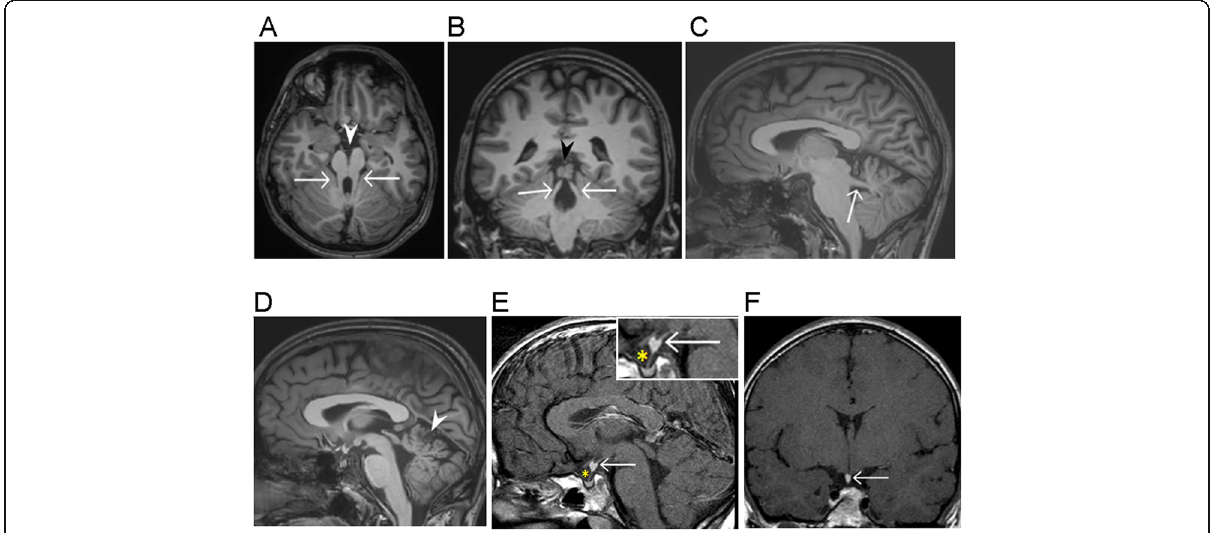
Fig. 2 a - d Molar tooth sign in JBTS. Axial ( a ), coronal ( b ) and sagittal ( c ) T1-weighted images show large, thickened, elongated superior cerebellar peduncles (arrows). Note a deep interpeduncular fossa (white arrowhead) and the vermian cleft (black arrowhead). Midsagittal ( d ) T1-weighted image shows vermian hypoplasia (white arrowhead). e-f Ectopic posterior pituitary lobe. Postcontrast sagittal and coronal T1-weighted images show a posterior pituitary lobe (arrow) located at the level of the upper infundibulum. A very thin infundibulum is seen (asterisk) (magnified in the right upper corner of